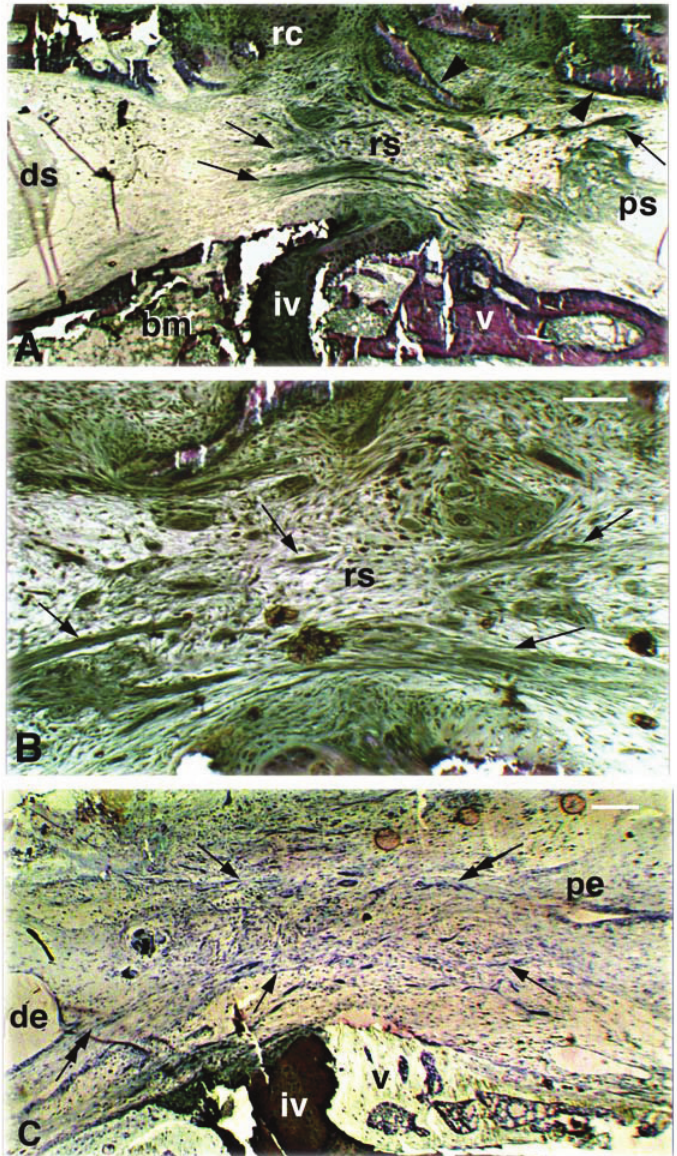
Figure 3. Histological longitudinal section showing the restored spinal cord at 29 days post-lesion. A , general view of the connective tissue and of the nervous bridge located between the two stumps of the spinal cord. Bony fragments of the neural arch (arrowheads) that was cut by the surgical intervention to reach the spinal cord. Arrows point to nervous bundles crossing the bridge. Scale bar, 0.2 mm. B , detail on the glial-connective tissues present in the gap region with sparse bundles of nervous fibers (arrows). Scale bar, 0.1 mm. C , other detail of the lesion spinal cords showing the proximal and distal ependymal dilatations (ampullae) separated by the glia-connective tissues filling the gap (arrows indicate fibrous/nerve fibers; double arrows indicate fibers in continuity with the two ependymal ampullae). Scale bar, 0.1 mm. Legends: bm, bone marrow; de, distal ependymal ampulla; ds, distal spinal cord stump (downstream of the lesion); iv, inter vertebral cartilage; pe, proximal ependymal ampulla (enlarged); ps, proximal spinal cord stump (rostral to the lesion); rc, regenerated cartilage (vertebral repair); rs, regenerated/repaired spinal cord; v, vertebral